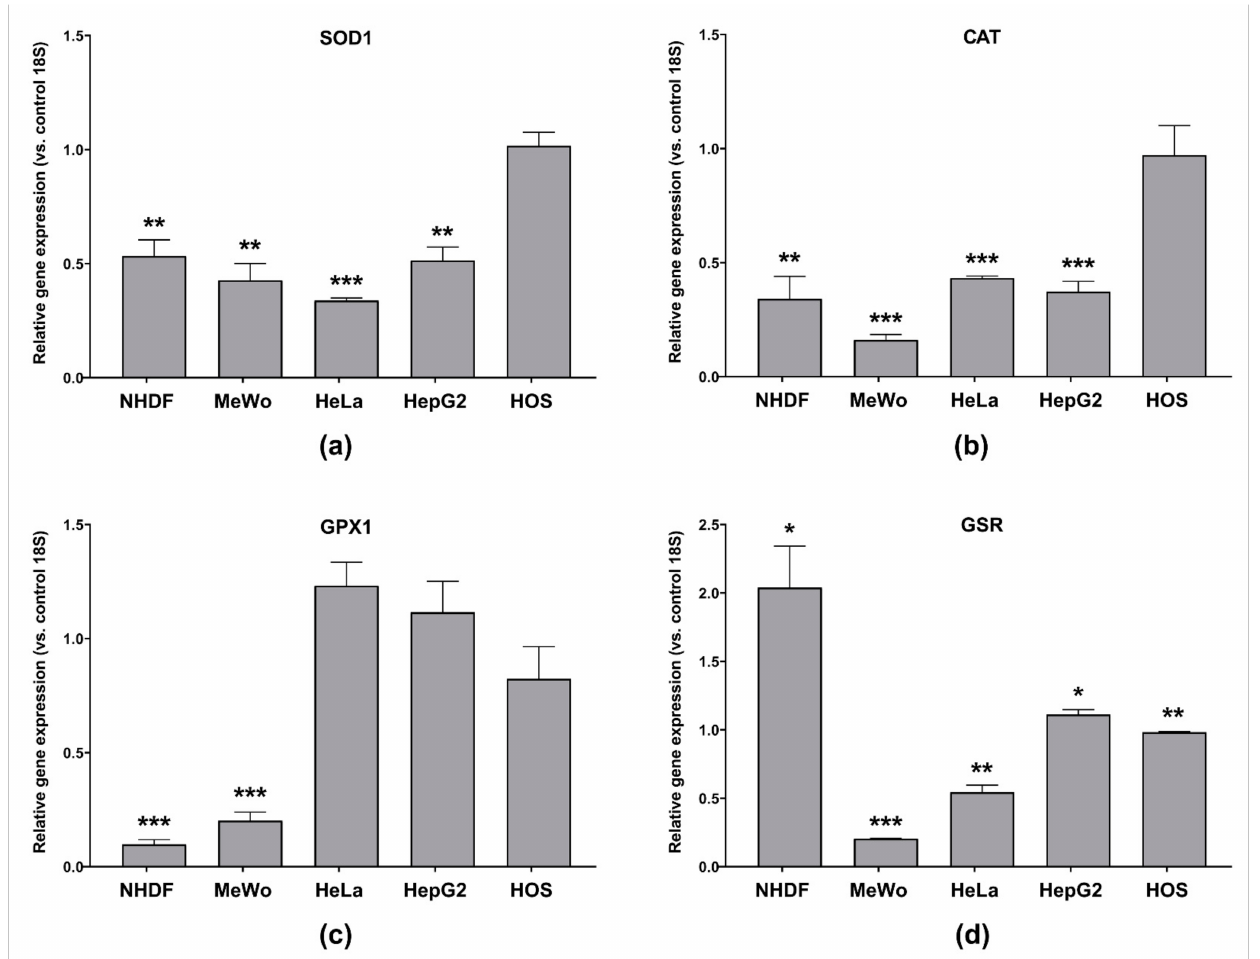
Figure 12. Gene expression of: ( a ) SOD1; ( b ) CAT; ( c ) GPX1; ( d ) GSR in normal dermal fibroblasts (NHDF), malignant melanoma (MeWo), adenocarcinoma (HeLa), hepatocellular carcinoma (HepG2) and osteosarcoma (HOS) cells treated with cell line-specific IC 50 of CBD-enriched hemp oil for 48 h. Control cells were incubated with complete cell culture medium. Experiments were done in triplicate, obtained data were expressed as mean 2 − ∆∆ Cq values (vs. 18S of control cells) ± standard error of the mean. * p < 0.05, ** p < 0.01, *** p < 0.001 vs. control cells (SOD1: NHDF p = 0.003067, MeWo p = 0.001484, HeLa p < 0.000001, HepG2 p = 0.001186, HOS p = 0.796912; CAT: NHDF p = 0.002620, MeWo p = 0.000004, HeLa p < 0.000001, HepG2 p = 0.000146, HOS p = 0.821580; GPX1: NHDF p = 0.000002, MeWo p = 0.000027, HeLa p = 0.057635, HepG2 p = 0.337276, HOS p = 0.267738; GSR: NHDF p = 0.019436, MeWo p < 0.000001, HeLa p = 0.001320, HepG2 p = 0.026340, HOS p =